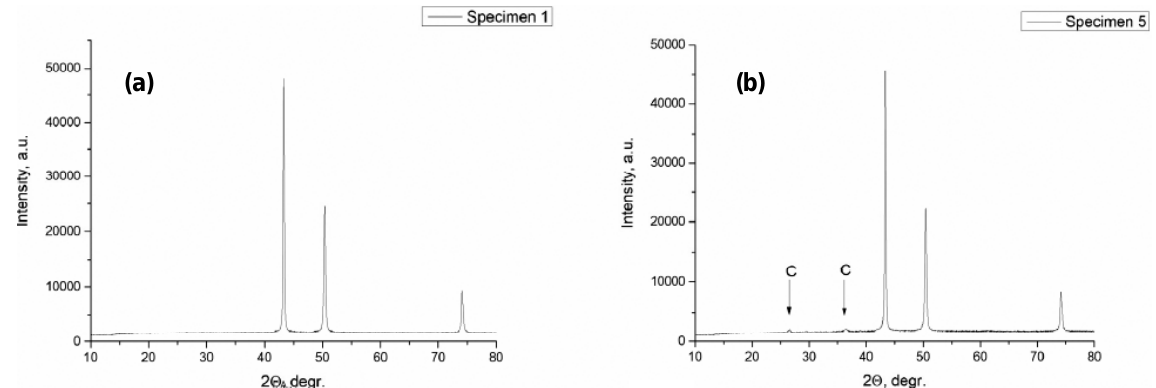
Fig. 2. XRD patterns of (a) Specimen 1 and (b) Specimen 5 after